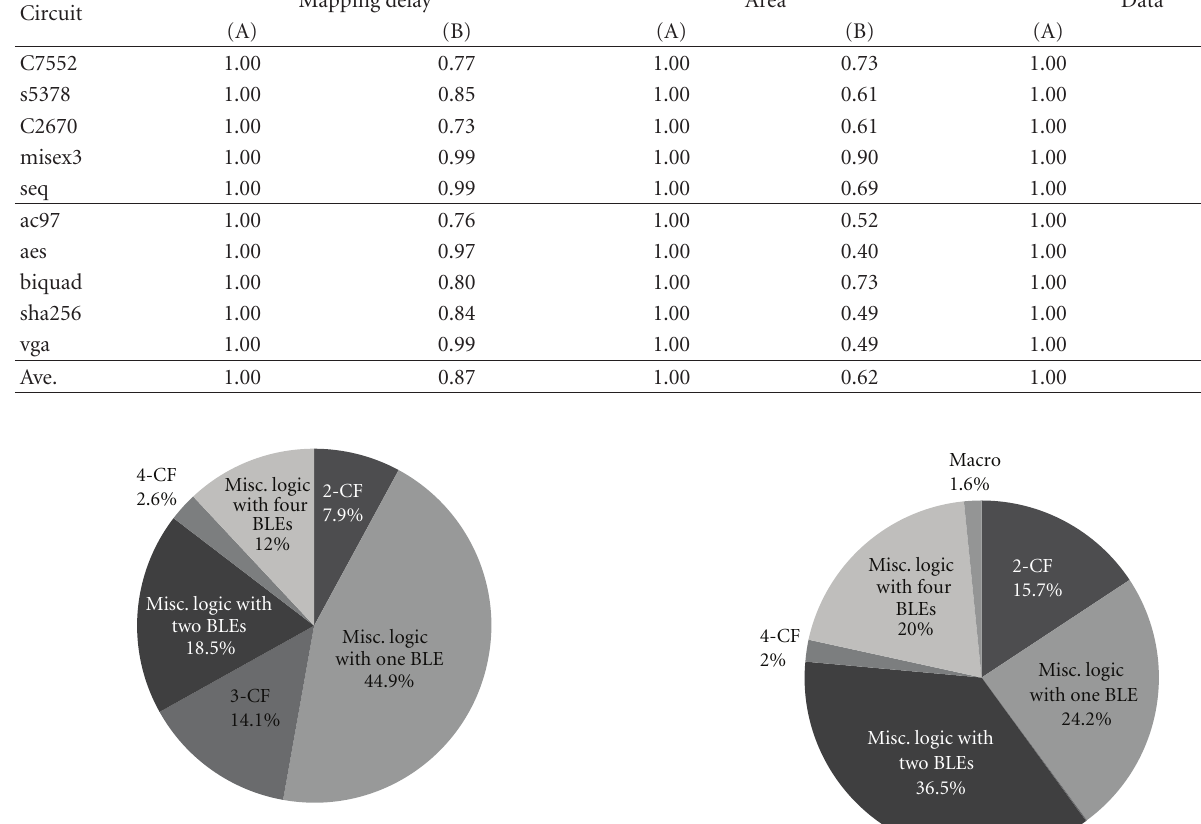
Figure 14: Ratio of Misc. Logic (five MCNC benchmarks).